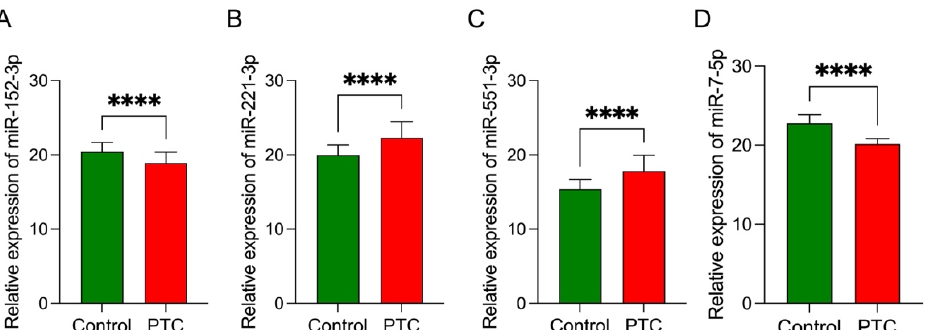
Figure 5. Relative expression of DEMs included in the logistic regression model in control (N = 39) and PTC samples (N = 41): ( A ) miR-152-3p (Fold change (FC) = 0.37); ( B ) miR-221-3p (FC = 5.78); ( C ) miR-551b-3p (FC = 5.68); ( D ) miR-7-5p (FC = 0.18). Each bar represents the geometric mean ± standard error of mean of the ratio of miRNA expression and reference miRNAs (miR-103a-3p and U6 snRNA) calculated using the qBase MSExcel VBA based on multiple samples and multiple reference miRNAs. Asterisks indicate the levels of significance of differences (**** p < 0.0001); Mann–Whitney U-test was used to compare PTC and control samples. PTC, papillary thyroid cancer. FC values were provided using the GeneGlobe Data Analysis Center.